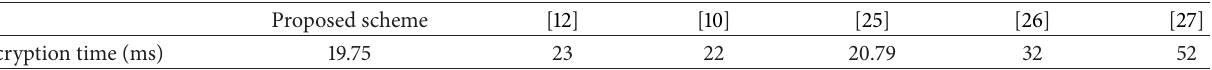
Table 3: Comparison of encryption time for proposed algorithm with recent similar